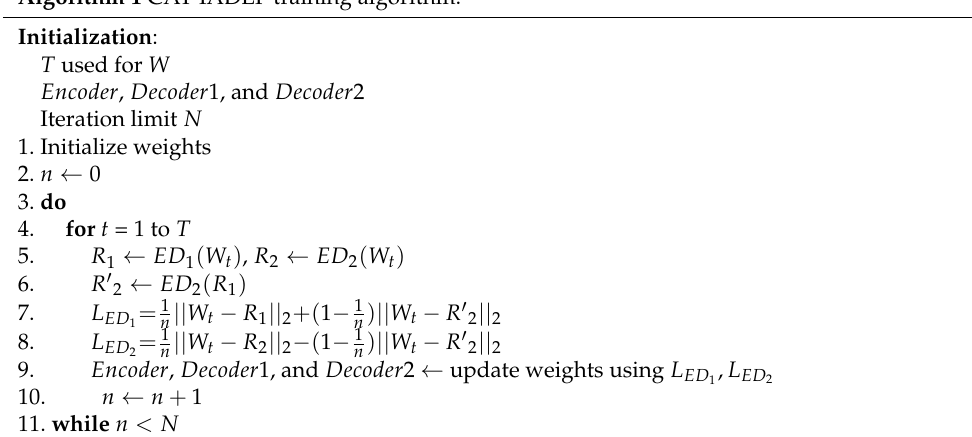
Algorithm 1 CAT-IADEF training